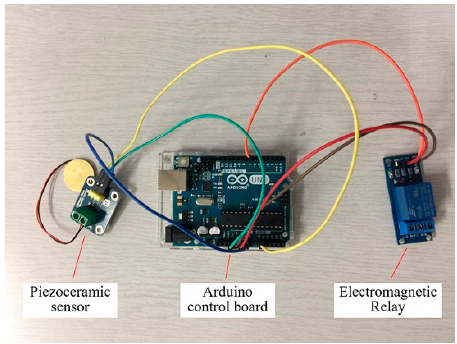
Figure 11. Configuration of the control system.